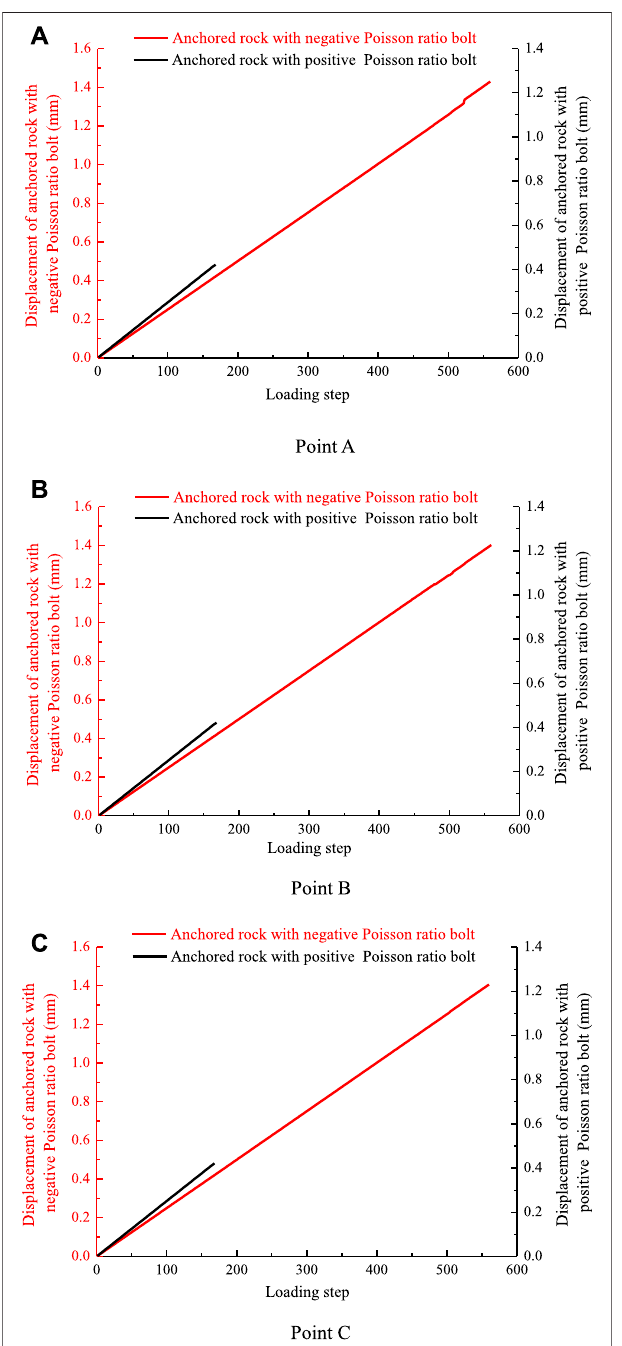
FIGURE 5 | Displacement comparison curves of points A, B, and C of two kinds of anchored rock. (A) Point A. (B) Point B. (C) Point C.